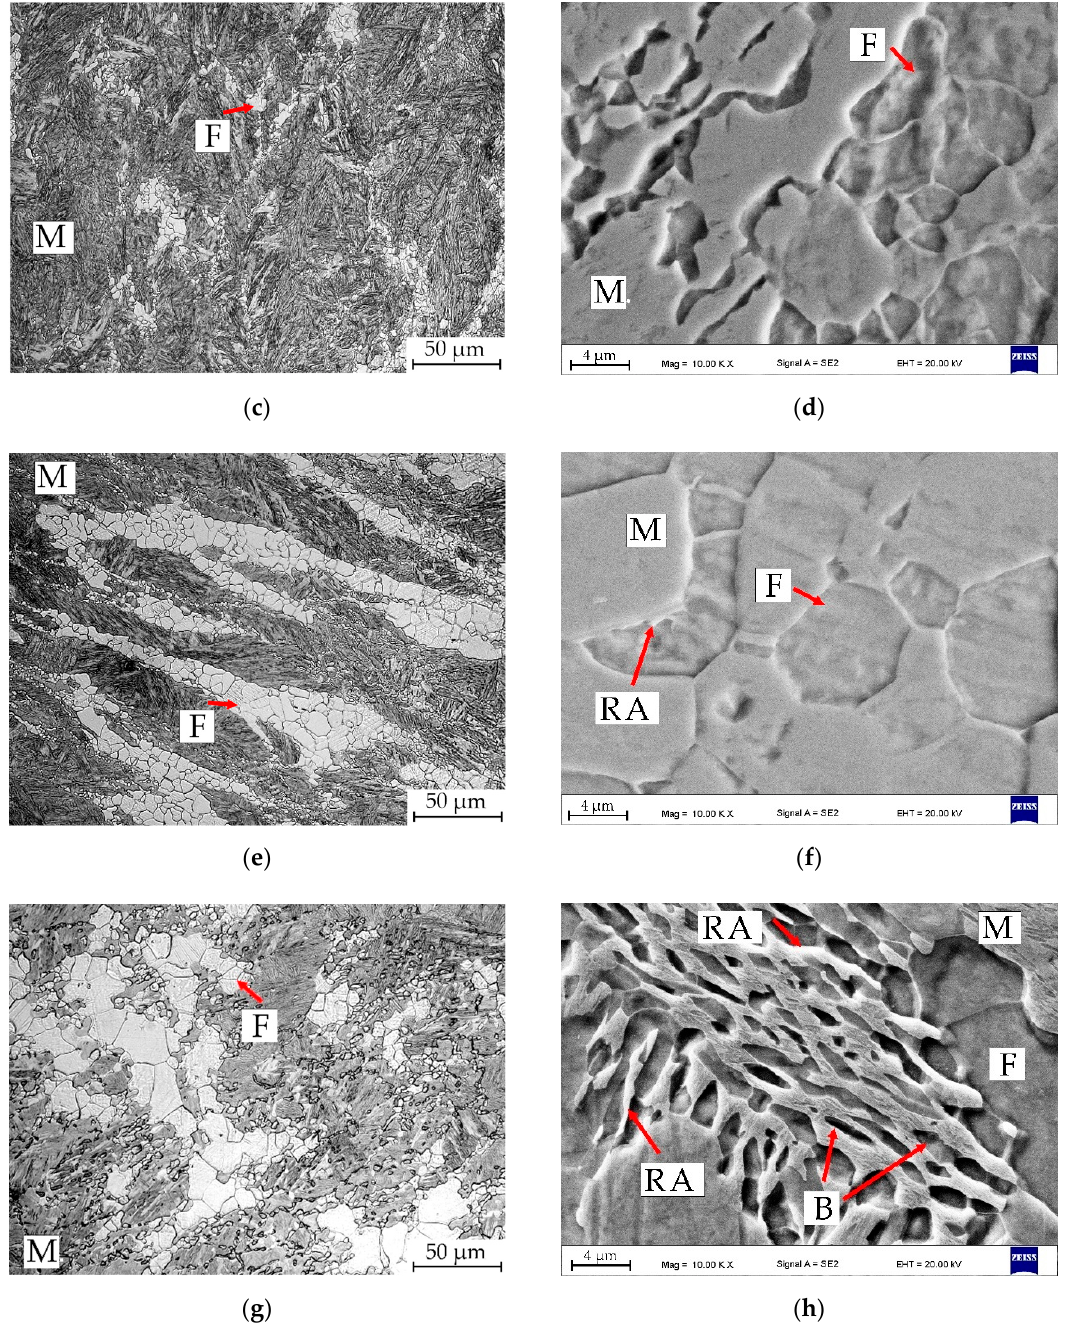
Figure 6. Light and SEM microscopic images of deformed samples: ( a , b ) sample 600D; ( c , d ) sample 650D; ( e , f ) sample 700D; ( g , h ) sample 750D; M—martensite; F—ferrite; B—bainite; RA—retained austenite.